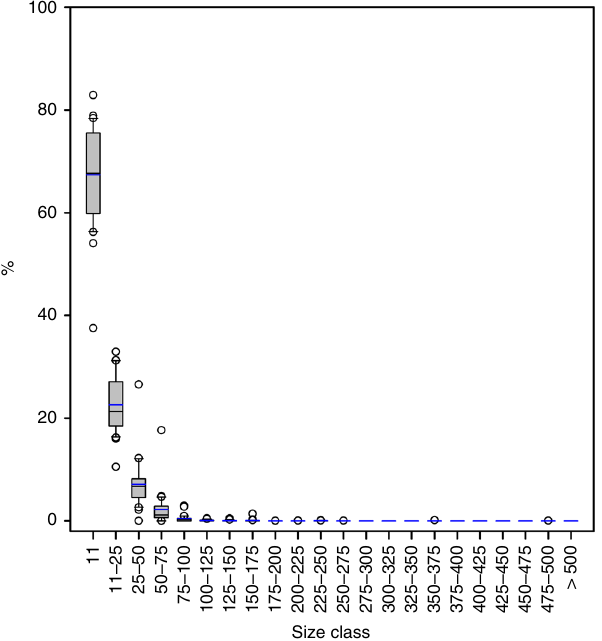
Fig. 3 Size classes of observed microplastic particles. Box and whiskers plot of percentage (%) shares of MP numbers in different size classes in all sea ice cores. The boundary of the box closest to zero indicates the 25th percentile, the line within the box marks the median and the boundary of the box farthest from zero indicates the 75th percentile. Whiskers (error bars) above and below the box indicate the 90th and 10th percentiles. Blue lines indicate the mean and black circles indicate outliers Figs. 1 and 4). Overall, the MP composition of the sampled sea ice